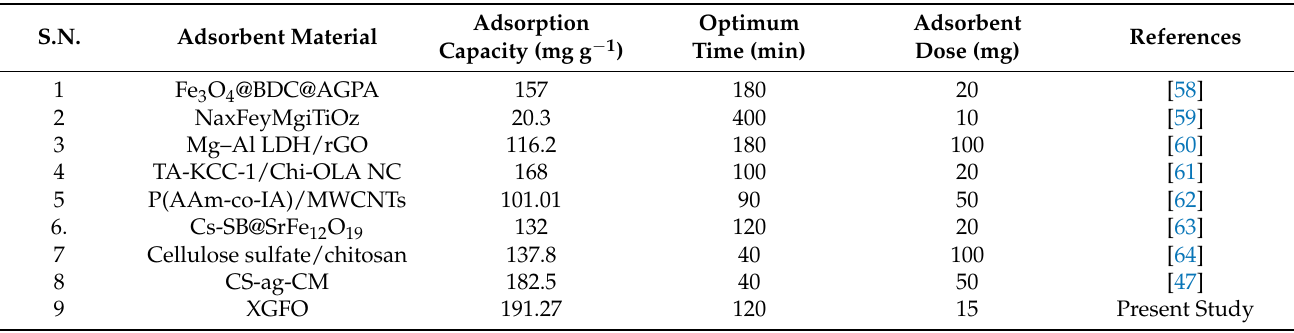
Table 4. Comparison with other materials in the